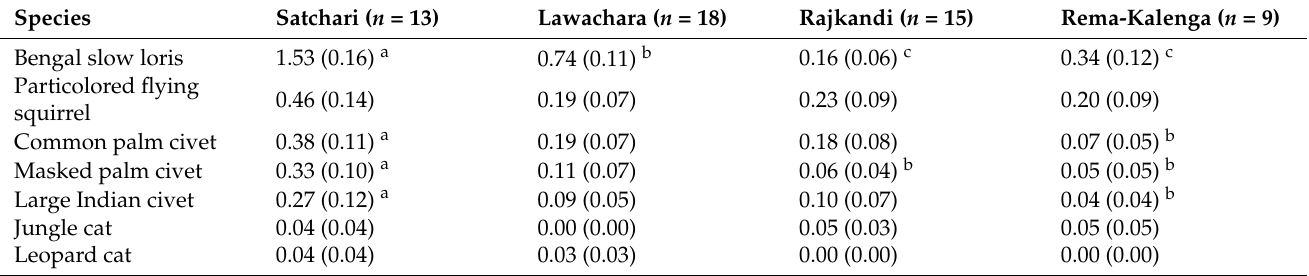
Table 2. Encounter rates (individuals km − 1 ; mean and standard error) of nocturnal animals in four sites in Bangladesh. The number of transects for each site is given between brackets. Superscripts indicate significant differences following Sequential Bonferroni post hoc